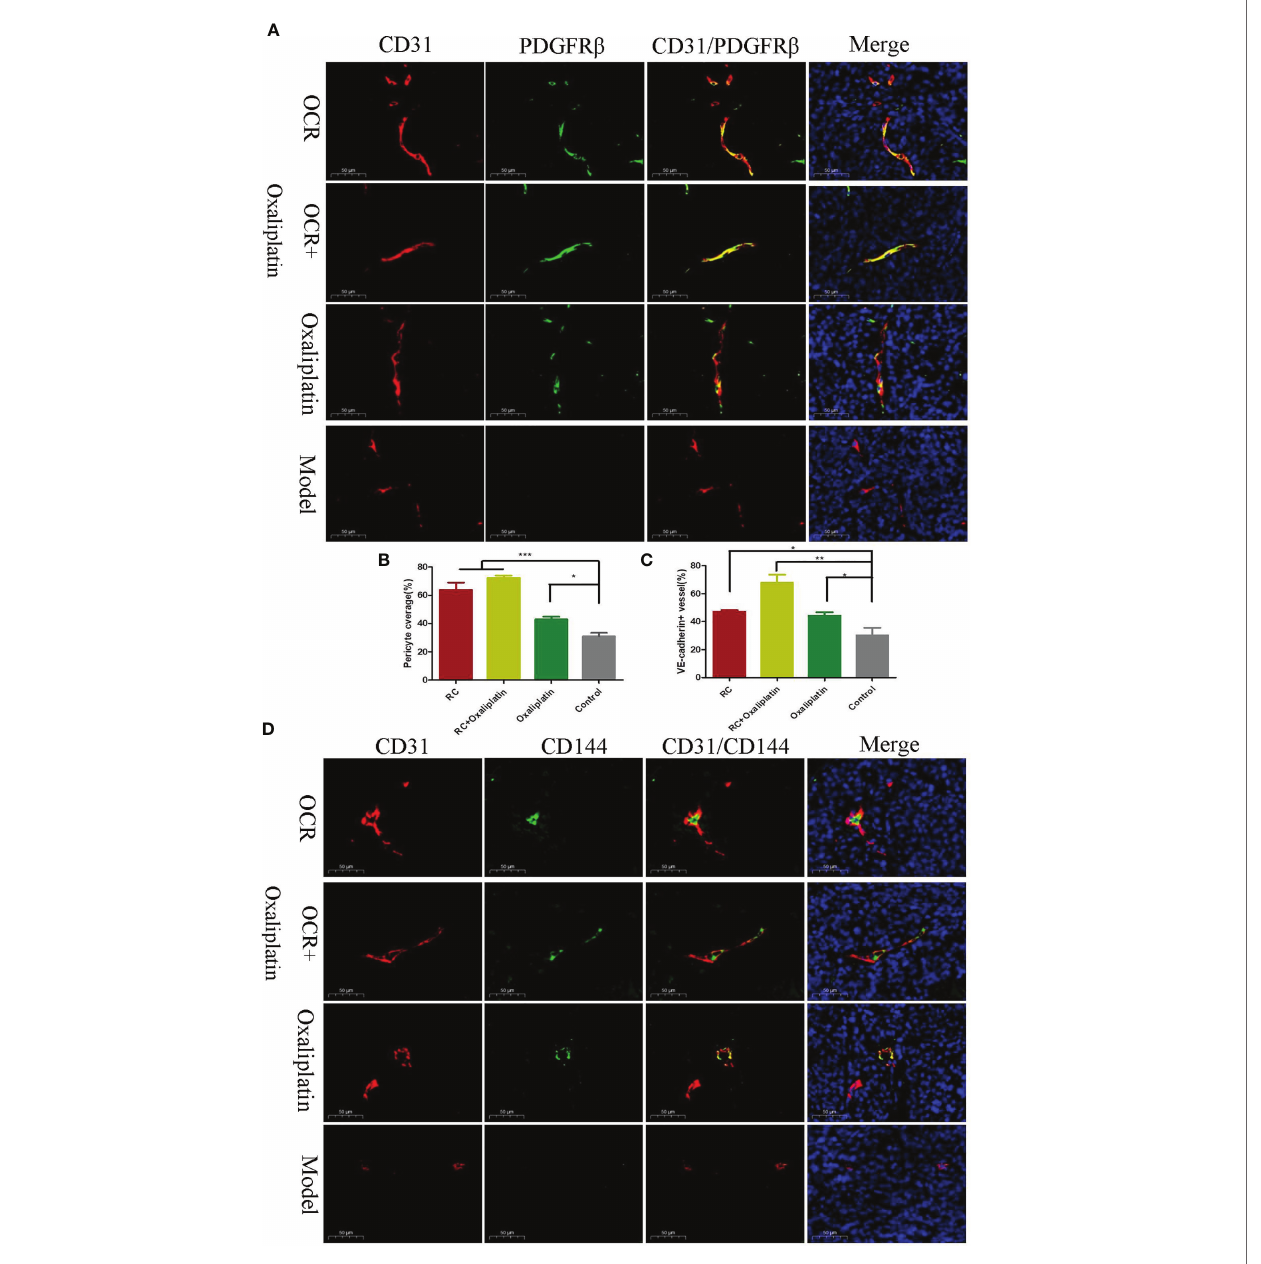
FIGURE 6 | The effects of essential oil from Curcumae rhizoma (CR) (OCR) on tumour blood vessel normalisation. (A, B) Tumour pericyte coverage in different groups. (C, D) VE-cadherin tumour coverage in different groups. (n = 5, mean ± standard deviation (SD), ***P < 0.001, **P < 0.01, *P < 0.05 compared with the control